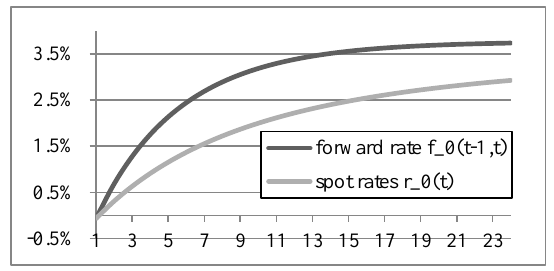
Figure 2. Initial spot rates r 0 ( t ) and forward rates f 0 ( t − 1, t )